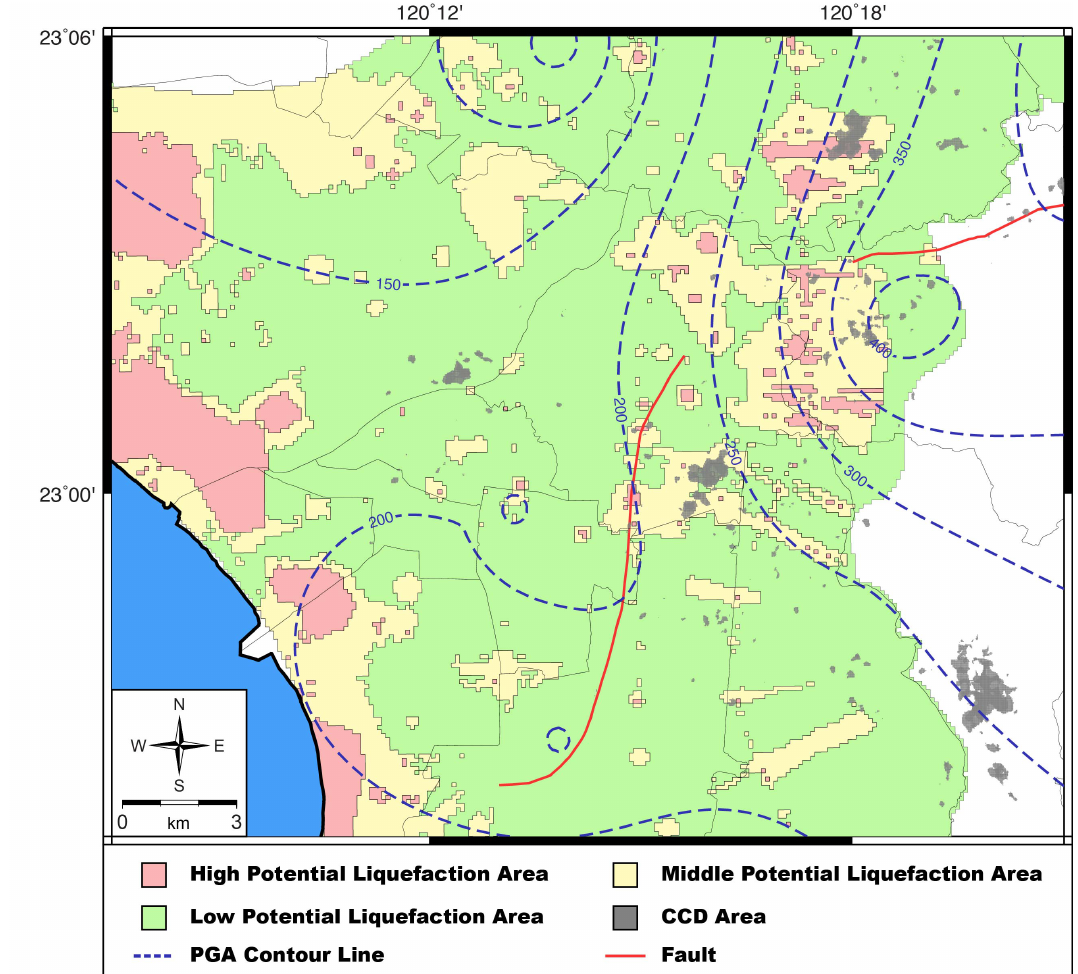
Figure 9. The comparison of CCD with liquefaction potential and peak ground acceleration (PGA) maps. The dark gray areas show the CCD results. The liquefaction potential map was classified into three categories. The high, middle and low potential areas are marked as red, yellow and green, respectively. The blue dashed lines are the PGA contour map (modified from Wu et al.